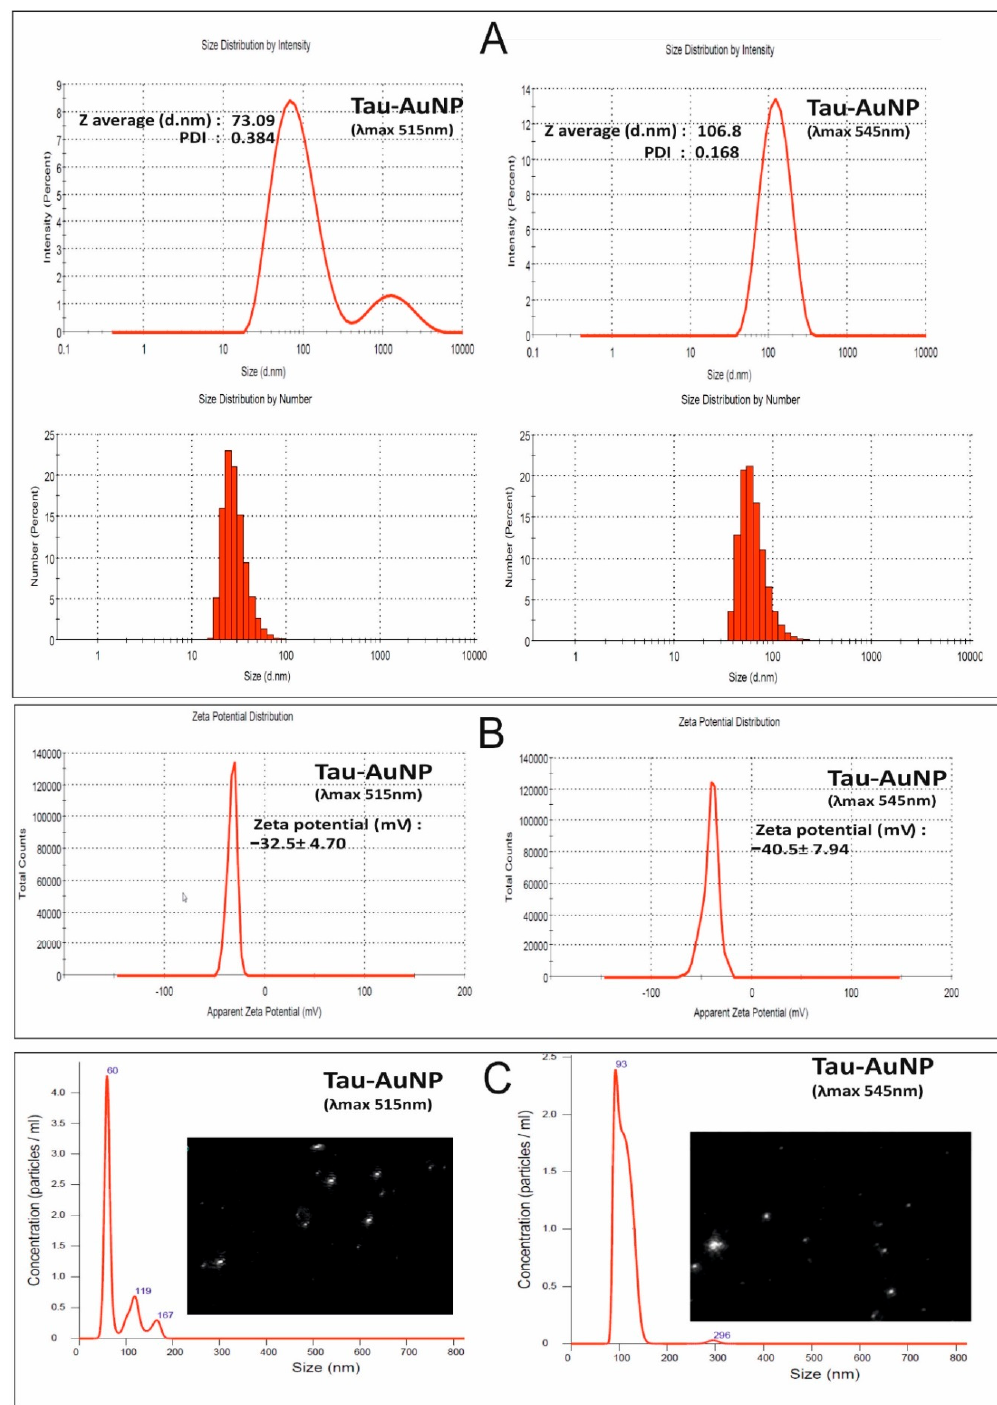
Figure 4. Dynamic Light Scattering DLS measurements showed the average size 73.9 and 106.8 nm with polydispersity index (PDI) values of 0.384 and 0.168, respectively, for the taurine-capped AuNP with λ max 515 and λ max 545 nm. The histograms show the size distribution of the taurine-capped metal gold nanoparticles (AuNPs), as shown in ( A ). Zeta potential measurements show a negative surface charge for the taurine-capped metal gold nanospheres at pH 3.30, as shown in ( B ). ( C ) Nanoparticle tracking analysis (NTA) measurements for taurine-capped gold nanoparticles determining their average size and Brownian motion (white spots depict nanoparticle